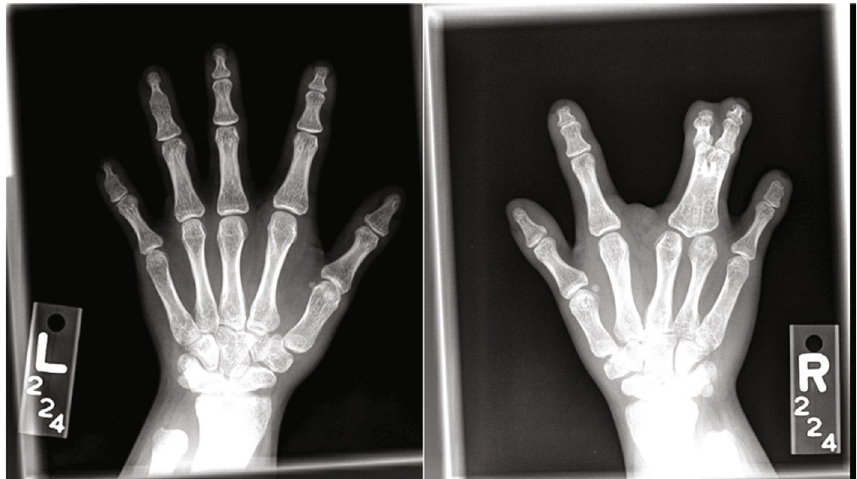
Figure 1: Hand XR of this patient demonstrates multiple skeletal deformities on both the left (ulnar shortening, shortened fi rst metacarpal, hypoplastic phalanges, fusion of the middle and distal phalanges of the 4th and 5th digits) and right (ulnar shortening, shortened fi rst metacarpal, hypoplastic phalanges, bony and soft tissue syndactyly of the 3rd and 4th proximal phalanges) hand and wrist.